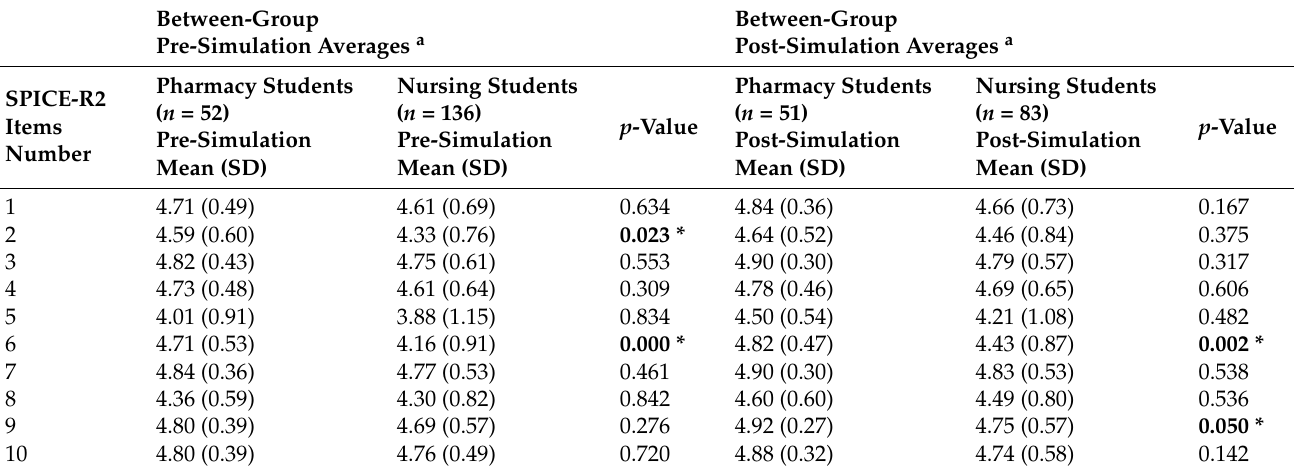
Table 3. Comparison of between-group differences in average scores pre- and post-simulation.